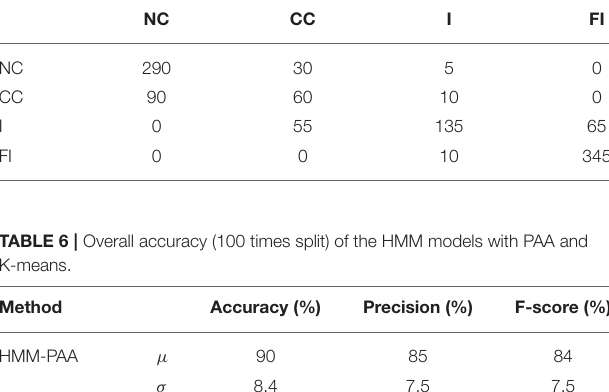
TABLE 1 | Confusion matrix of model 1 for Peg 1 clearance c = 0.11 mm , where NC, no contact; CC, Chamfer-Crossing; I, insertion; FI, full insertion.